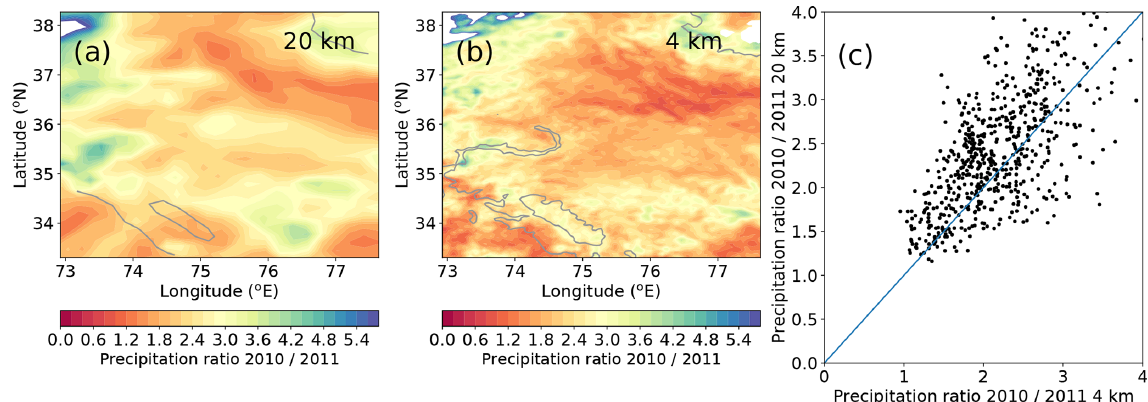
Figure 16. Precipitation ratios between May and September of 2 years for the WRF run at 20km with cumulus parameterization (a) , run at 4km resolution without parameterization (b) , and the two compared when binned at the resolution of the 20km run (c) . The 2000m elevation contour is indicated by a solid line.